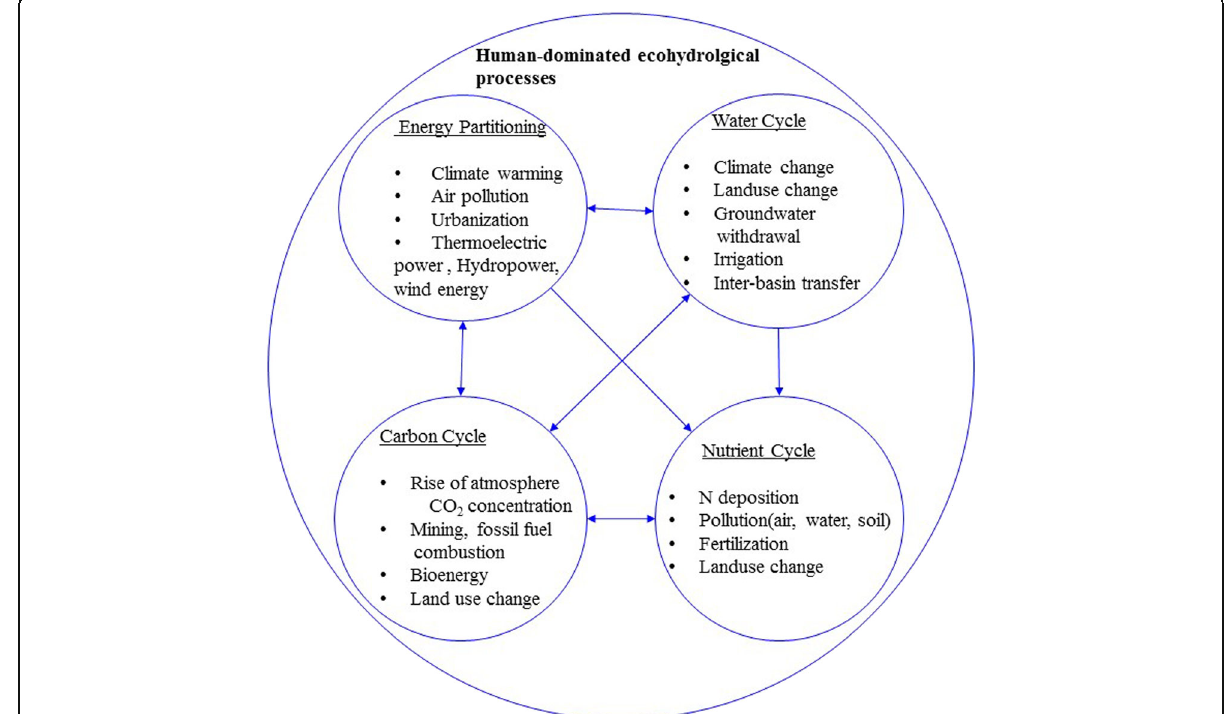
Fig. 2 A schematic overview of the inter-connected ecohydrological processes in human-dominated ecosystems. Human activities in the Anthropocene have permanently altered all aspects of the natural energy, water, carbon, and nutrient cycles by influencing the energy and material inputs to the biosphere, the hydrosphere, and the